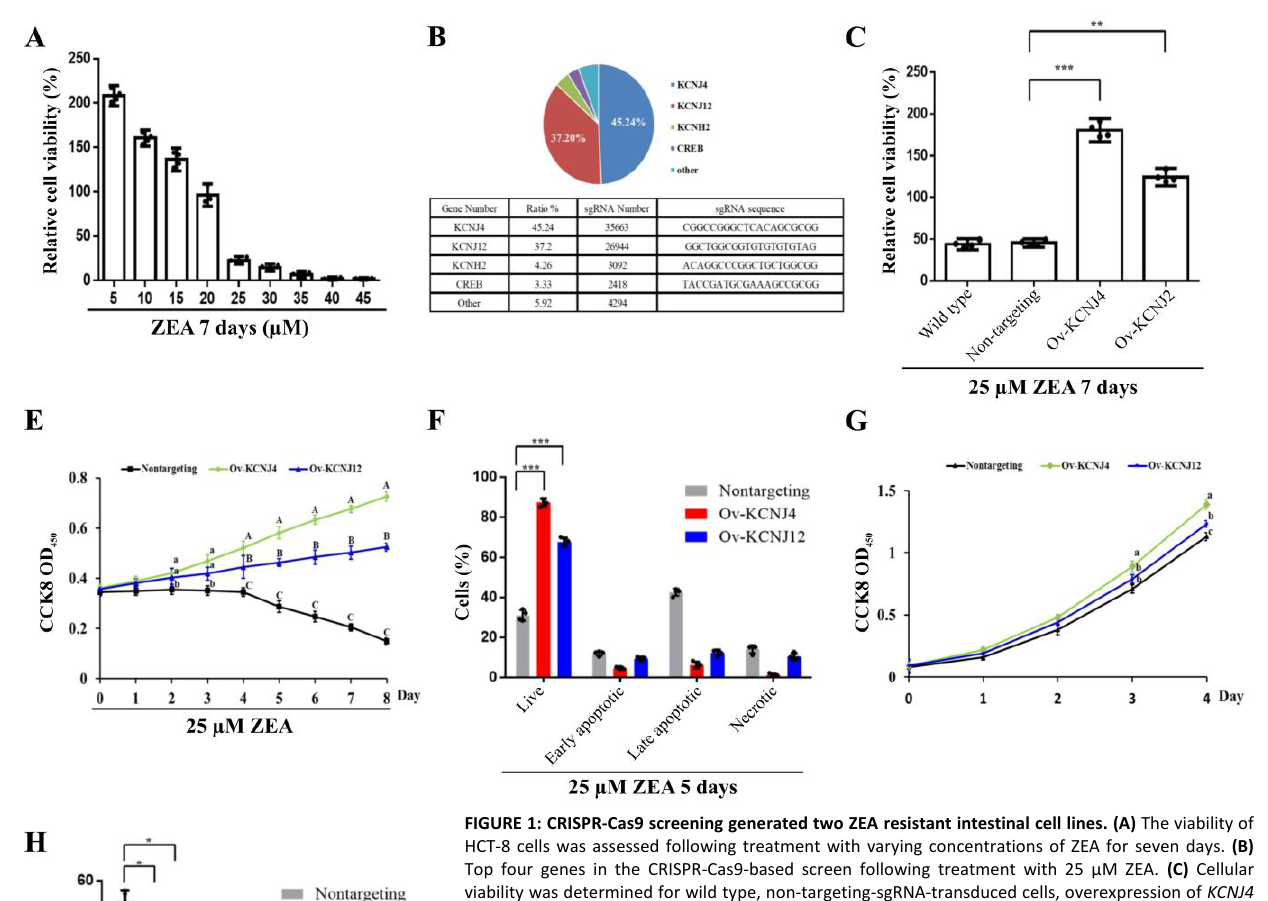
FIGURE 1: CRISPR-Cas9 screening generated two ZEA resistant intestinal cell lines. (A) The viability of HCT-8 cells was assessed following treatment with varying concentrations of ZEA for seven days. (B) Top four genes in the CRISPR-Cas9-based screen following treatment with 25 µM ZEA. (C) Cellular viability was determined for wild type, non-targeting-sgRNA-transduced cells, overexpression of KCNJ4 and KCNJ12 for seven days. (D) The three cell lines with the indicated tags were counted daily to assess their survival after treatment with 25 µM ZEA. (E) Percentages of necrosis, survival, and apoptosis were measured by PI/AnnexinV staining and flow cytometry. (F) The three cell lines were counted daily to assess their proliferation ability. (G) Cell cycle progression of the three cell lines was assessed. Data of figure D and figure F are expressed as means ± SEM. (n = 4/group). A two-way ANOVA with Bonferroni posttest was used for Figures D and F. A, B, C Values within a row with different superscripts differ significantly (P < 0.05); A, B, C Values within a row with different superscripts differ significant (P < 0.01). Other Data are presented as the mean ± SEM (n=4). p < 0.05 (*), p < 0.01 (**) and p < 0.001 (***), calculated by Student